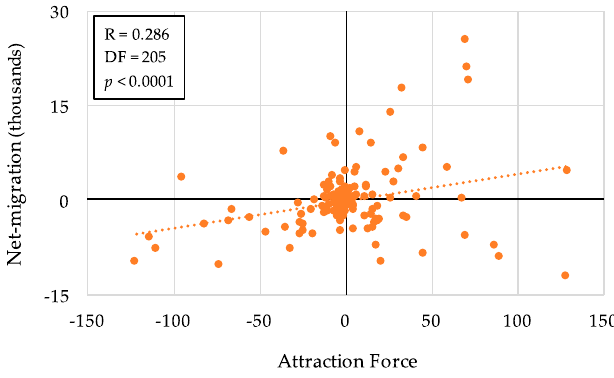
Figure 8. Population attraction forces in 2010 and observed net migration in 2011.